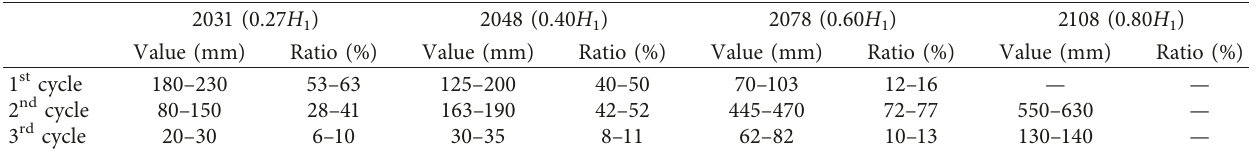
Figure 8: Evolution of settlement values with time in the Qiaoqi dam. (a) EL. 2061; (b) 2085m; (c) EL. 2110m. Table 6: The horizontal displacements of the Maoergai dam during every water cycle and the ratios of the displacement values to the total displacement observed during the three